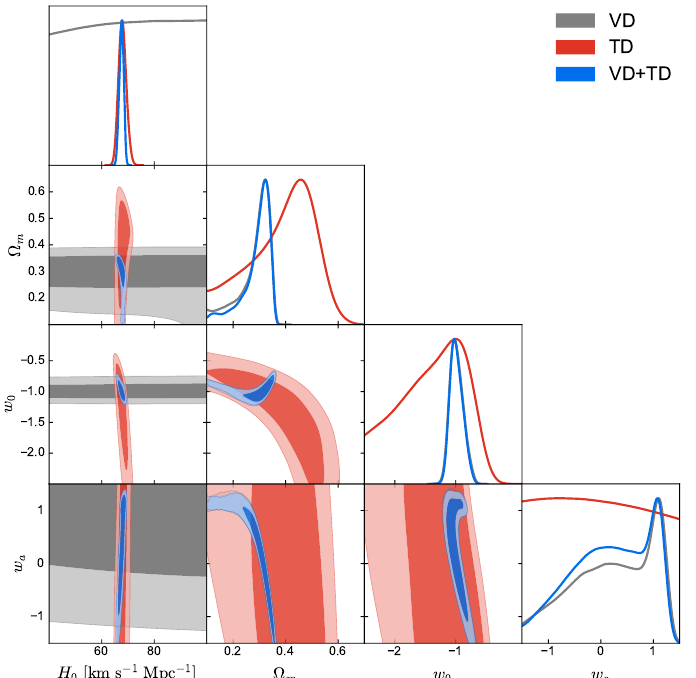
Figure 6. The constraints (68.3% and 95.4% confidence level) on the CPL model from the simulations of VD, TD, and VD+TD. Table 3. The constraints on cosmological parameters of the Λ CDM, w CDM and CPL models by using the simulated VD, TD, and VD+TD. For comparison, we also list the fit results from the